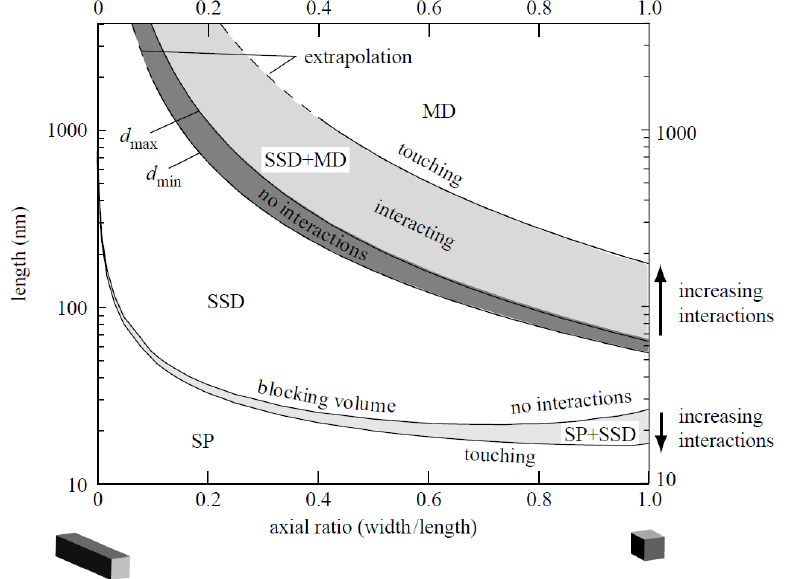
Figure 5. Diagram of magnetic states of magnetite; the regions of a stable single-domain (SSD) state are indicated for individual grains and for chains with and without taking into consideration Table 60. s below which all grains are considered to be in a superparamagnetic (SP) state where the direction of a magnetic moment of an individual grain is constantly changed by thermal agitation. For non-interacting grains, there is a range of grain sizes marked by d min and d max , where both SSD and multi-domain (MD) states are possible. Changes in both grain shape and volume contribute to the location of critical boundaries. Reprinted from [119], J. R. Soc. Interface, Vol. 6, Muxworthy